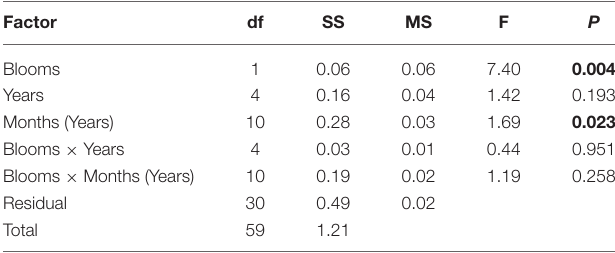
Shown are degrees of freedom (df), sums of squares (SS), mean squares (MS), F-ratios (F), and the Monte Carlo asymptotic P-values (P). Significant P-values are highlighted in